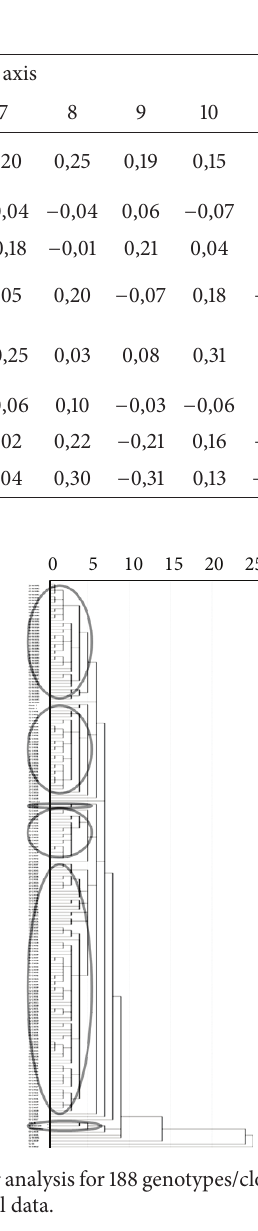
stipules (0.87), petiole: presence of pubescence of upper side (0.87), and petiole: intensity of pubescence of upper side (0.79). The remaining ten axes were related to other leaf, shoot, and plant traits (Table